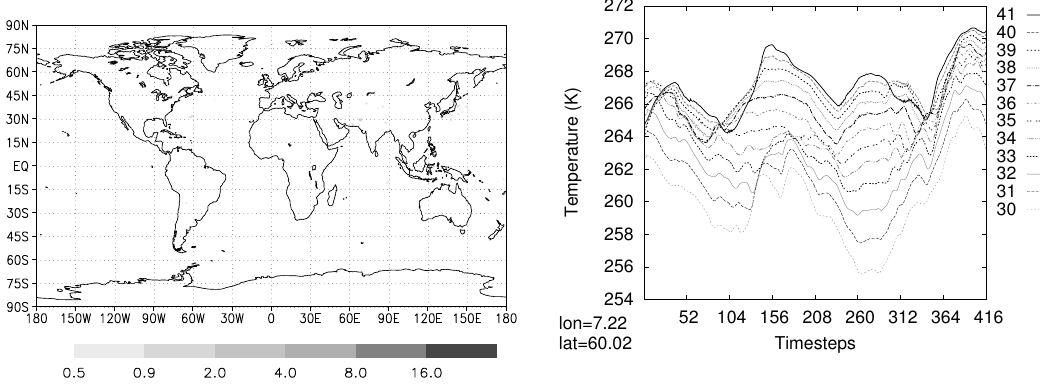
Fig. 11. The left figure shows the amplitude of 2∆ t temperature oscillations on the lowest model level (in Kelvin) after 96 hour forecast computed according to Equation 9 for the model run with the fibrillation amplifi- cation test of the large scale precipitation scheme but with cryoscopic cycle switched off. The figure on the right shows temperature (in Kelvin) in one model point on the 12 lowest model levels for each time-step during the 96 hour forecast for the model run with the fibrillation amplification test of the large scale precipitation scheme but with cryoscopic cycle switched off.